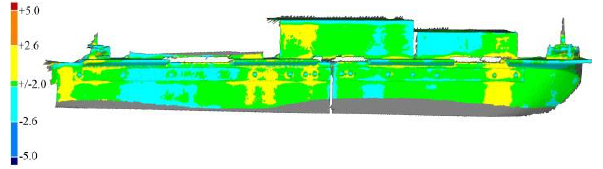
Figure 7: Colour coded inspection map between reference and geometrically corrected point cloud